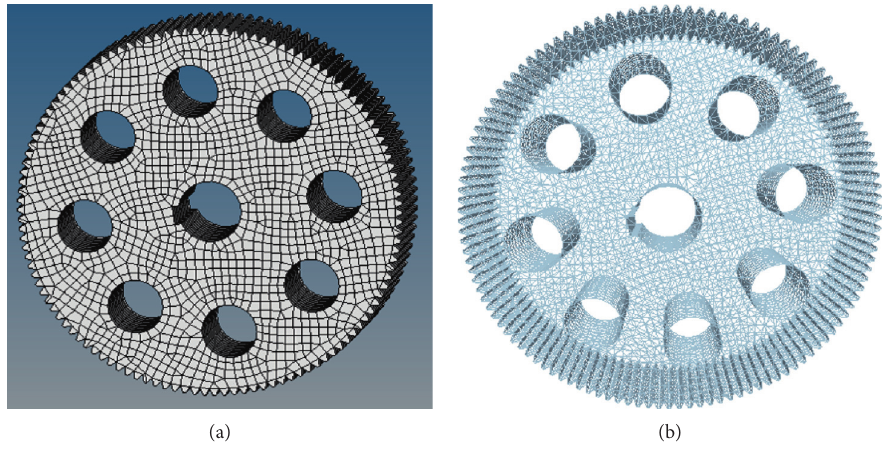
Figure 3: Gear transmission model. (a) Finite element model. (b) Discrete element